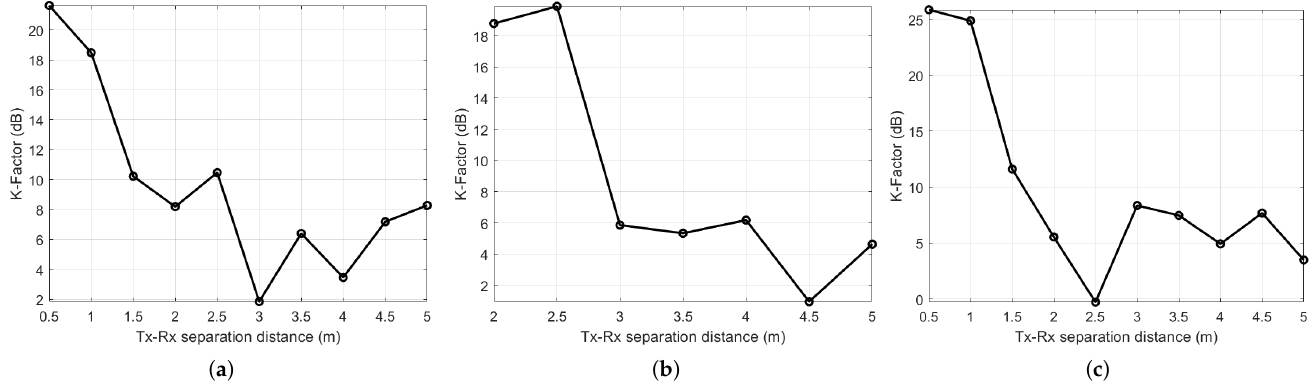
Figure 9. K-factor along with a measurement distance of 5 m in ( a ) the Manufacturing hall at Dokka Fastners AS, ( b ) Test room at Dokka Fastners AS, and ( c ) NTNU MANULAB.